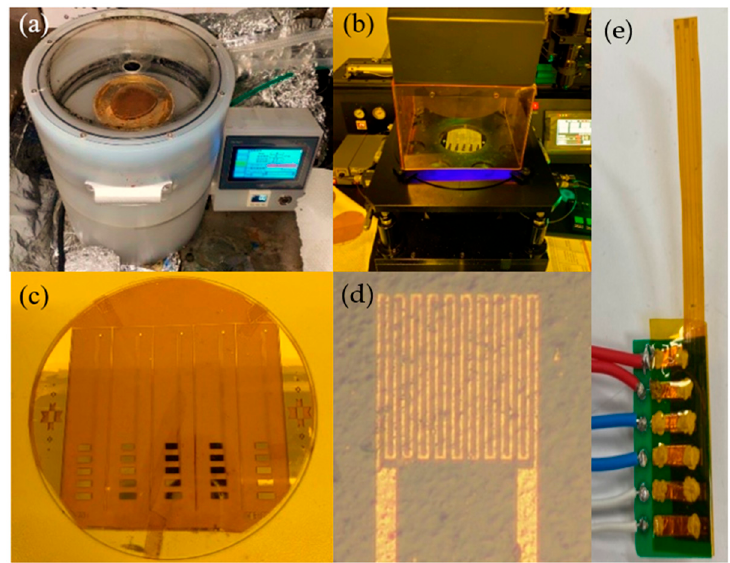
Figure 4. (a) Coating; (b) Exposure; (c) Lift ‐ off; ( d ) Optical micrograph of the flexible micro air ve ‐ Figure 4. ( a ) Coating; ( b ) Exposure; ( c ) Lift-off; ( d ) Optical micrograph of the flexible micro air locity sensor; ( e ) picture of the actual flexible micro air velocity sensor. velocity sensor; ( e ) picture of the actual flexible micro air velocity